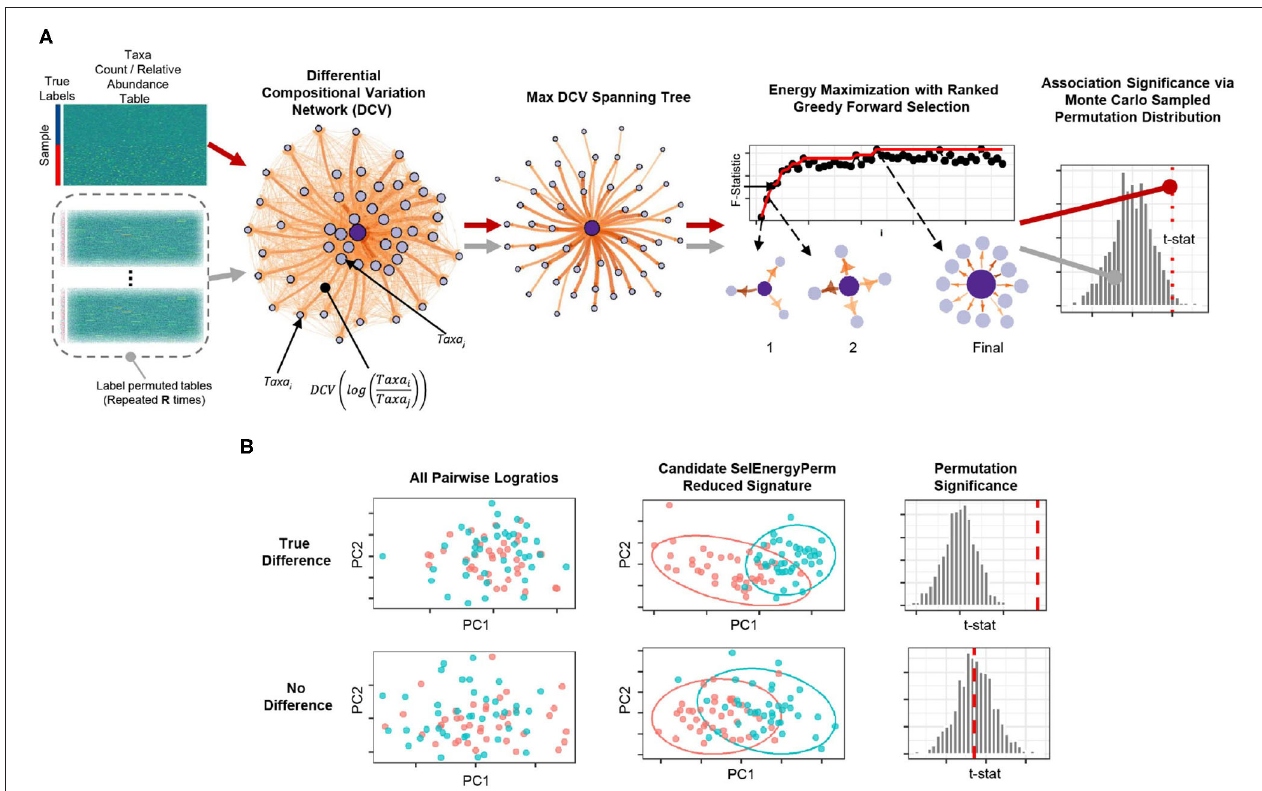
FIGURE 1 | Overview of the SelEnergyPerm framework for non-parametric group association testing in metagenomic data. (A) Relative abundance/count data are transformed using all pairwise logratios. These logratios are subsequently scored (DCV) and used to efficiently select a subset that: (1) is independent via a maximum spanning tree and (2) maximizes the energy or association between groups via greedy optimization. The entire process is repeated using permutation testing to control false discovery and assess statistical significance. (B) Detection/rejection of sparse associations hidden within high dimensional data via simultaneous feature selection and permutation